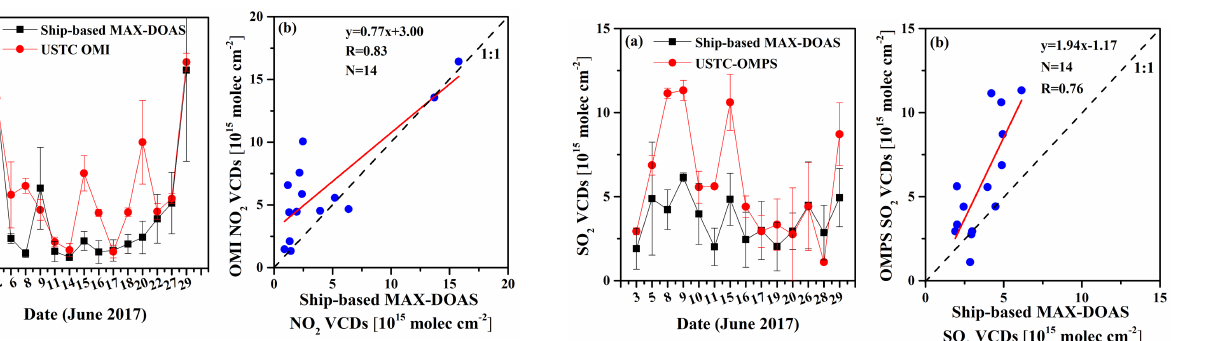
Figure 7. Time series (a) and correlation analysis (b) of the tropo- spheric SO 2 VCDs measured by ship-based MAX-DOAS and the OMPS satellite during this campaign.